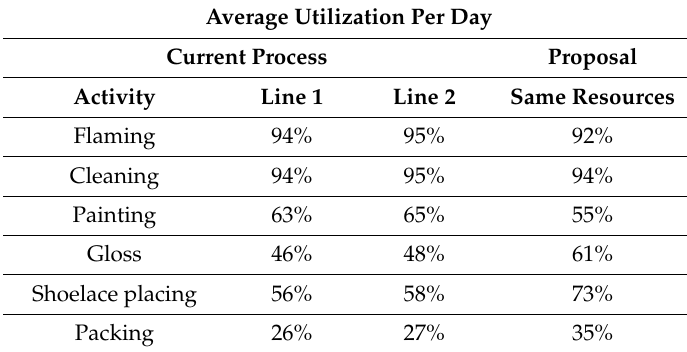
Table 4. Comparison of process indicators, average utilization per day: Current-Proposal.